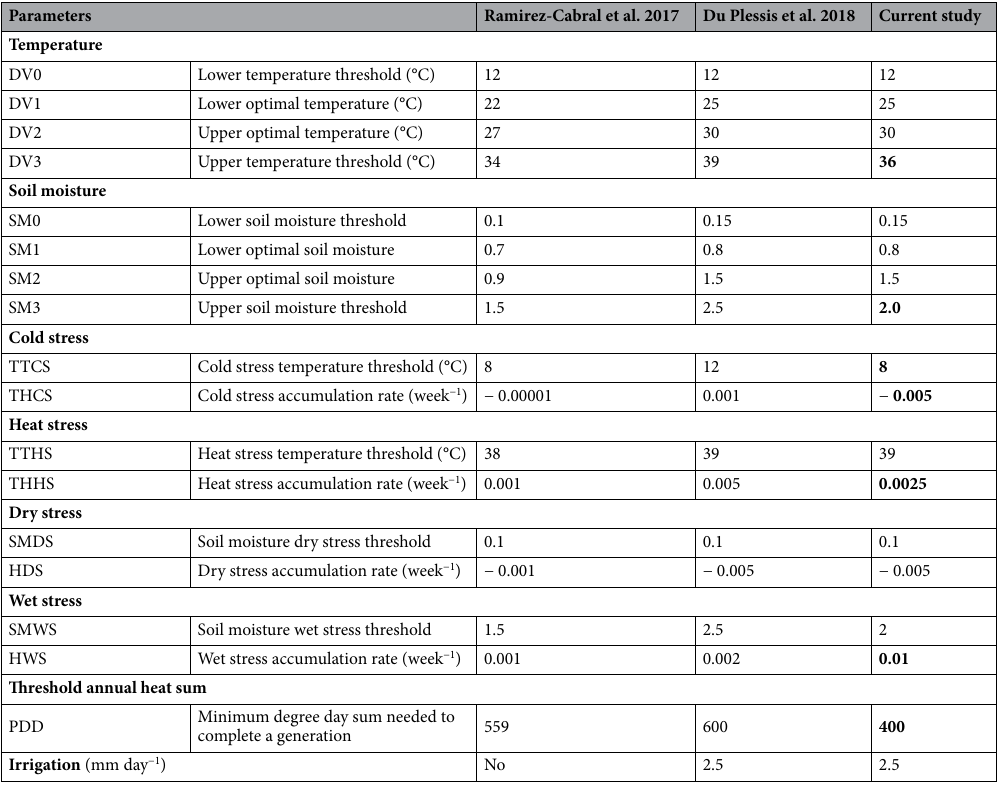
Table 1. CLIMEX parameter values used for modeling the distribution and invasion risk of FAW ( Spodoptera frugiperda ). Changes made to the Du Plessis et al. 35 parameter values are given in